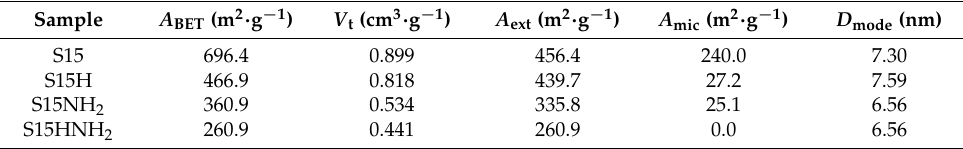
Table 1. Textural properties obtained from N 2 sorption at 76 K.